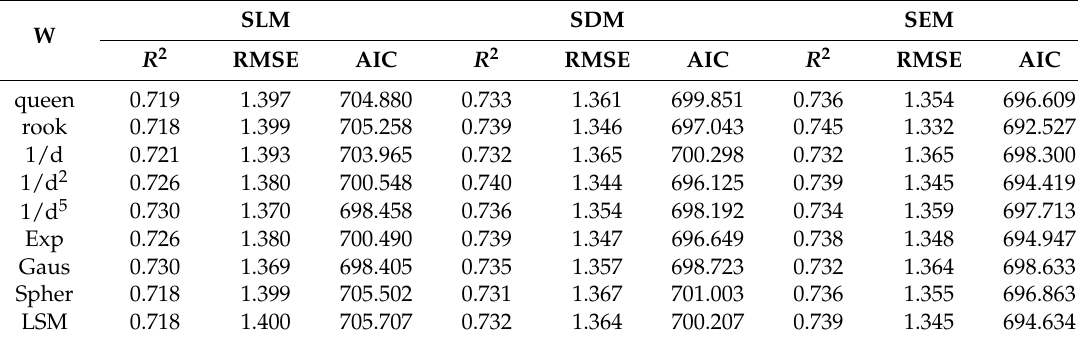
Table 3. Model fitting for three spatial autoregressive